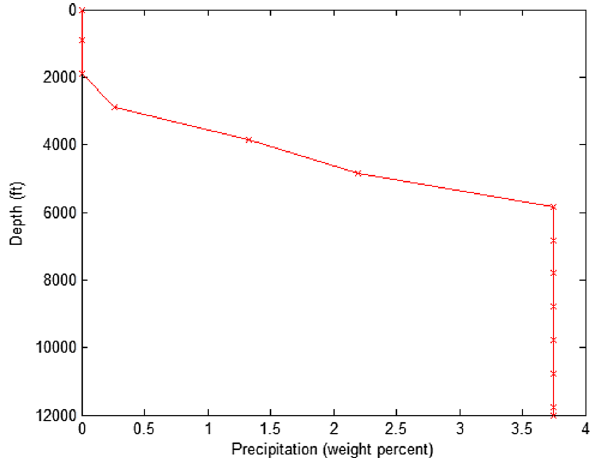
Fig. 11 Asphaltene precipitation profile in the well for choke size